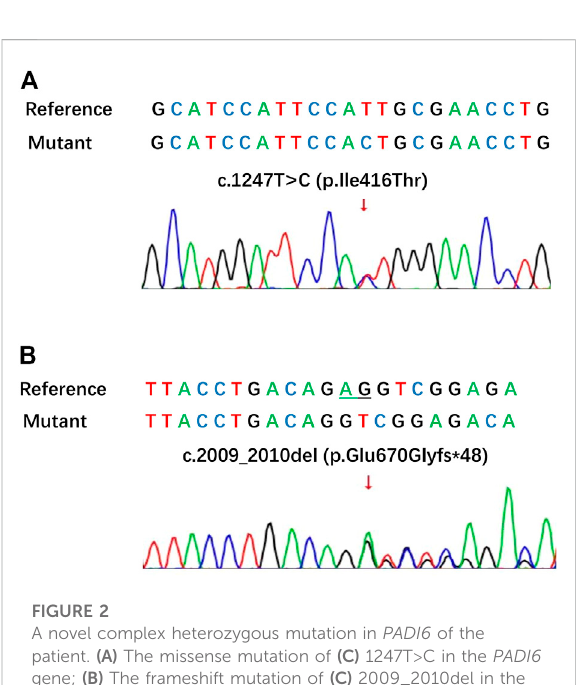
FIGURE 2 A novel complex heterozygous mutation in PADI6 of the patient. (A) The missense mutation of (C) 1247T > C in the PADI6 gene; (B) The frameshift mutation of (C) 2009_2010del in the PADI6